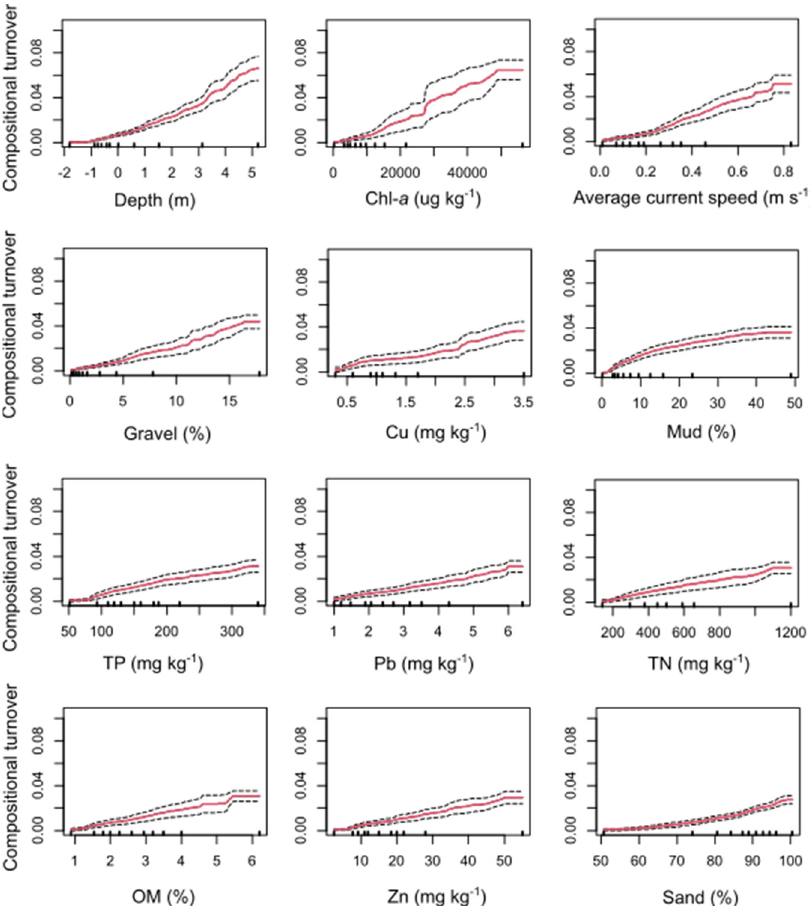
Figure 2. Cumulative importance curves (with 95% prediction intervals) visualizing the overall pattern of compositional turnover (in R 2 -importance units) for all species across all environmental predictors included in gradient forest models. Rug plots along the x-axis represent deciles across each environmental gradient.